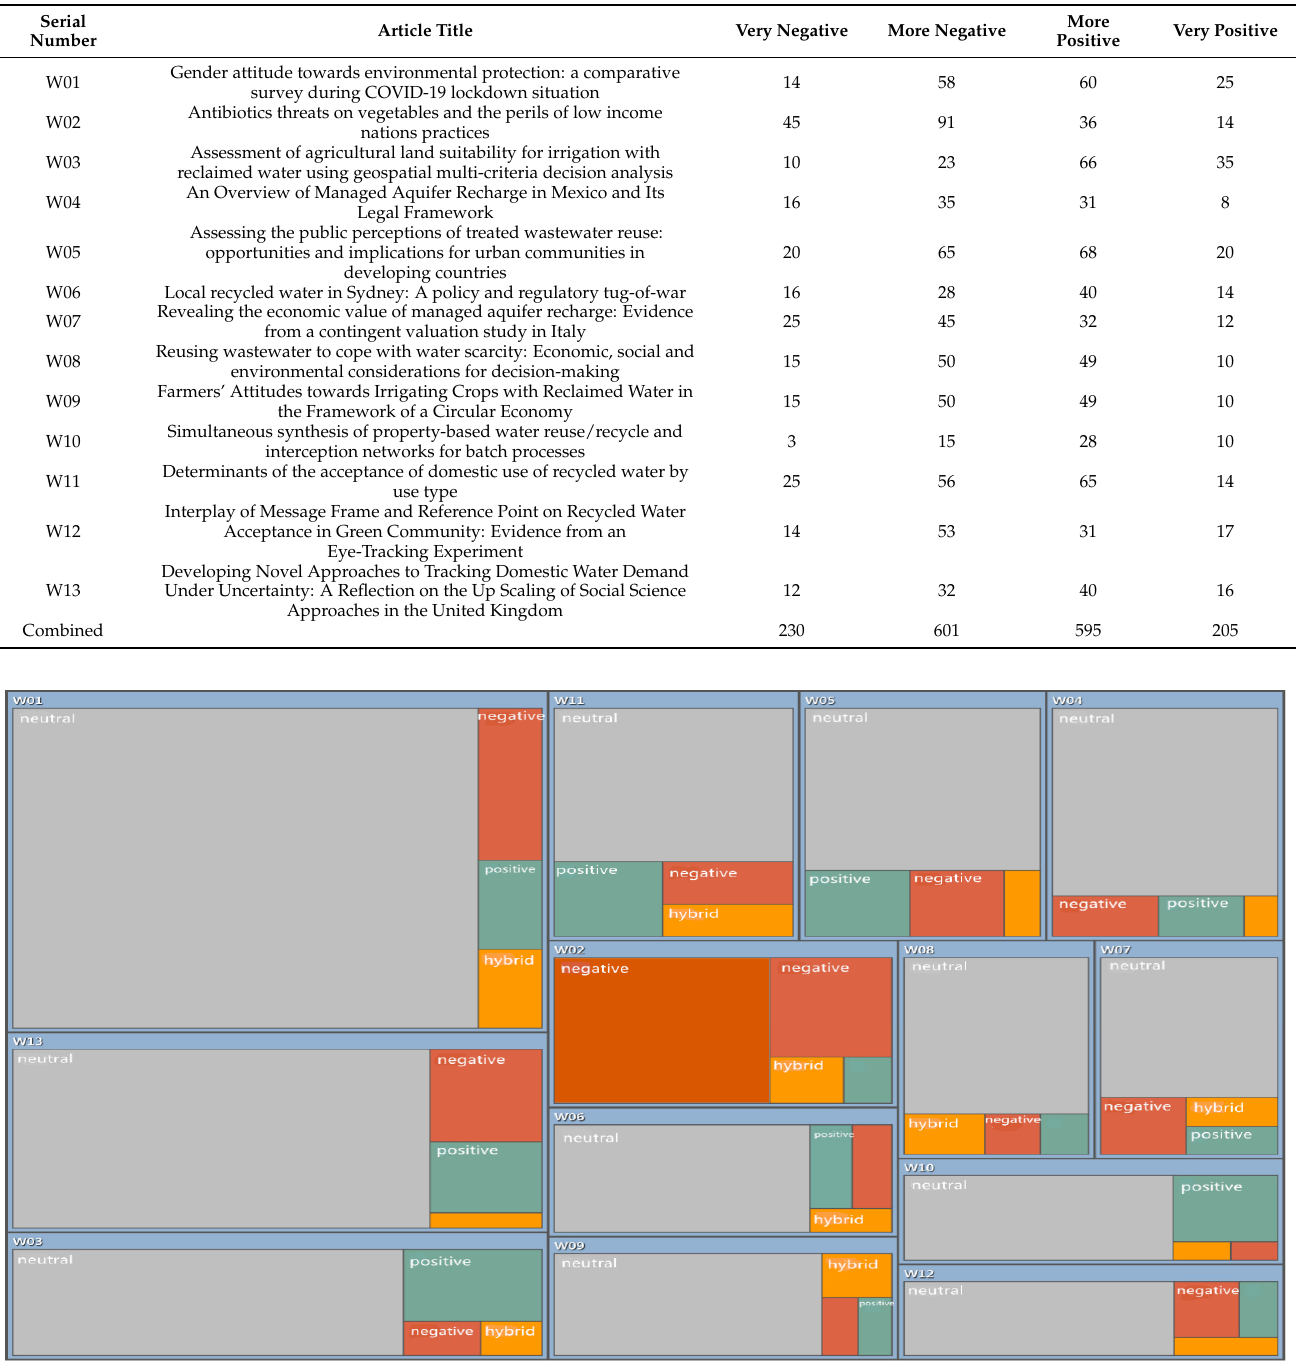
Table 11. Summary of results of sentiment analysis of highly cited literature in WOS.